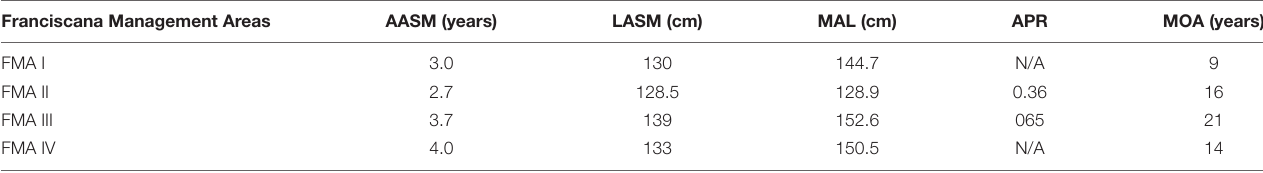
TABLE 1 | Spatial differences in age at attainment of sexual maturity (AASM), body length at attainment of sexual maturity (LASM), modeled asymptotic length (MAL), annual pregnancy rate (APR), and maximum observed age (MOA) of female franciscanas among FMAs (sensu Secchi et al., 2003a). Franciscana Management